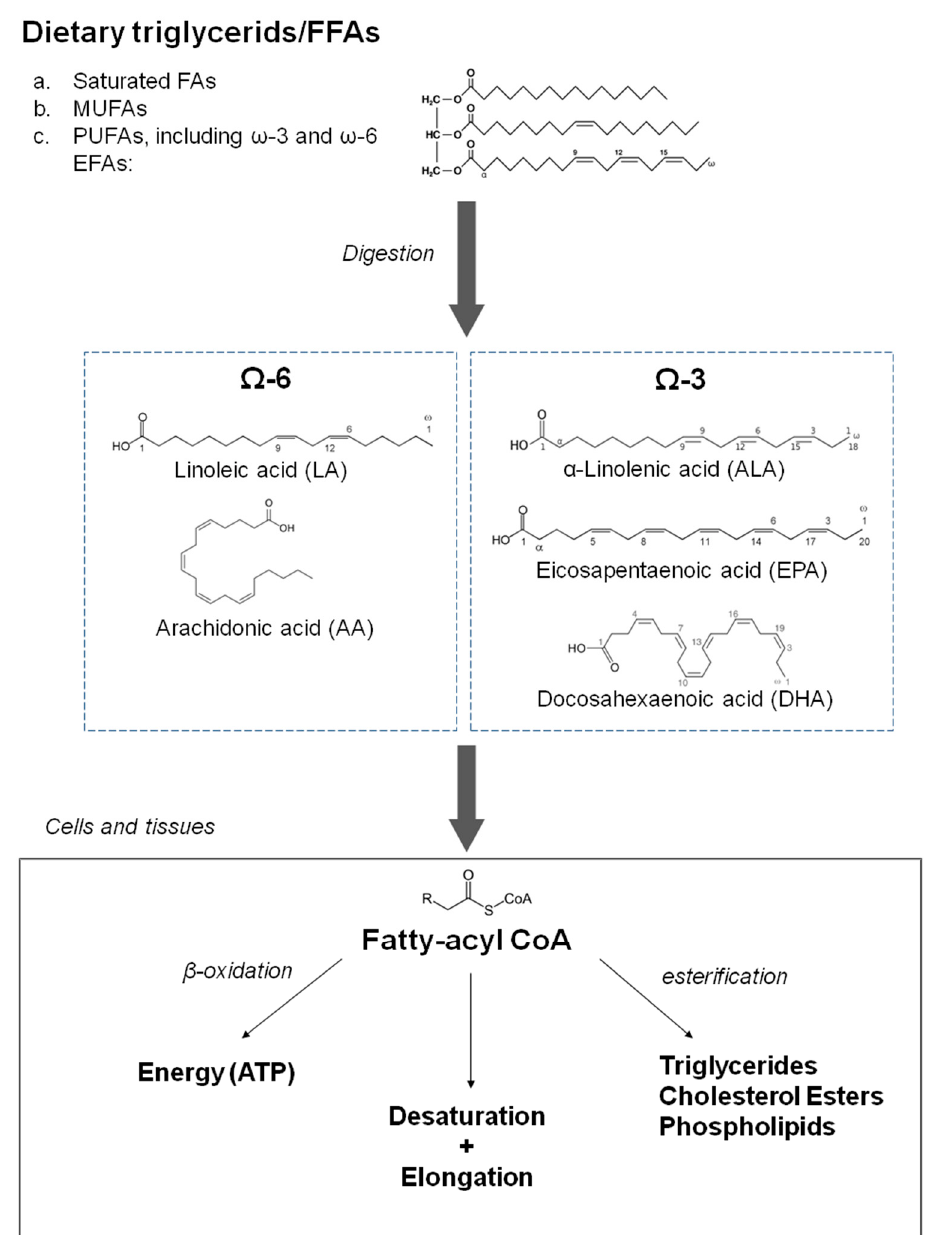
Figure 1. Characteristics of dietary fatty acids with a focus on omega-3 fatty acids and related com- pounds (source: Drenjan č evi ć , Ines et al. “The Effect of Dietary Intake of Omega-3 Polyunsaturated Fatty Acids on Cardiovascular Health: Revealing Potentials of Functional Food”. Superfood and Functional Food—The Development of Superfoods and Their Roles as Medicine, edited by Naofumi Shiomi, Viduranga Waisundara, IntechOpen, 2017. 10.5772/67033).